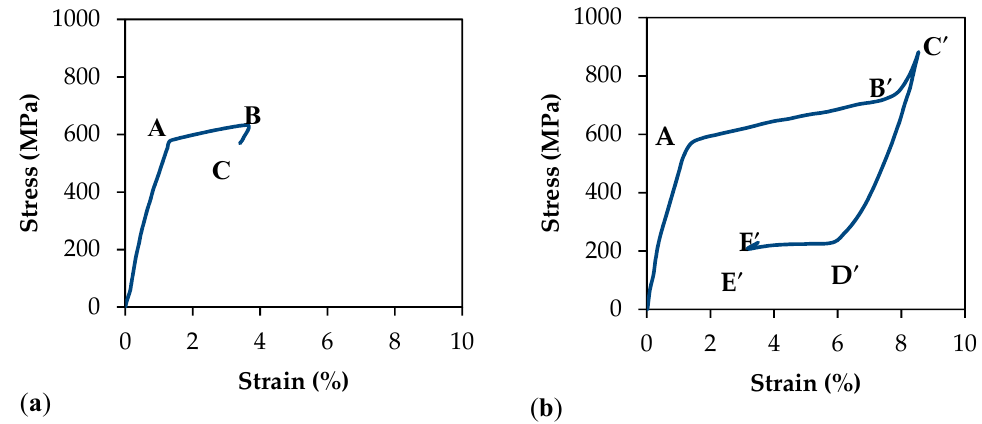
Figure A1. Stress-strain plots of superelastic NiTi wires: ( a ) The behavior of the superior wires during chewing (AB) and at rest (point C); ( b ) the behavior of the inferior wires during chewing (D’E’) and at rest (point F’).